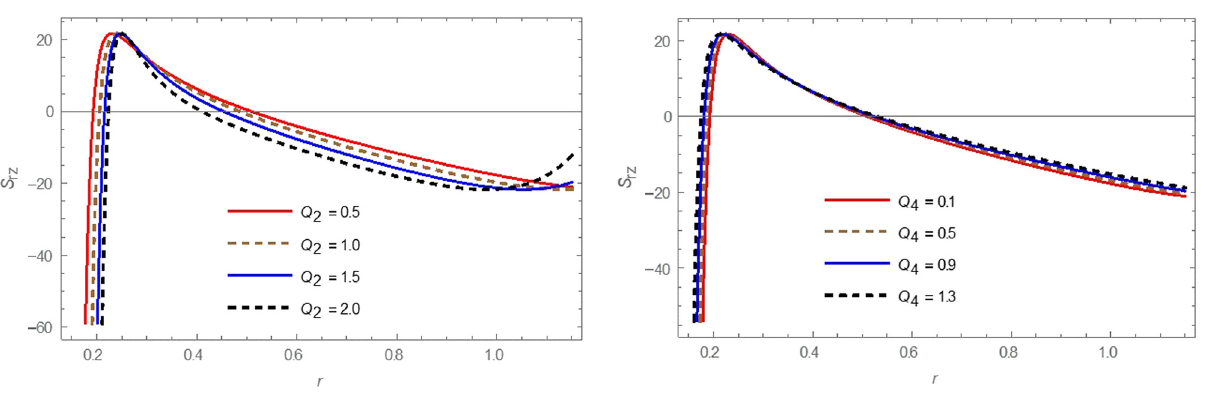
Figure 11: E ff ect of di ff erent values of Q 2 on stress with W